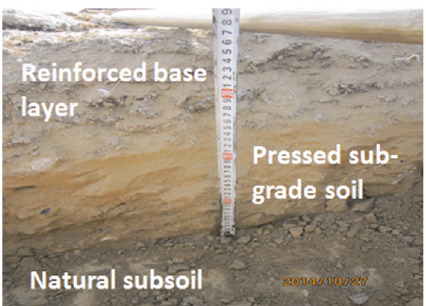
Figure 13: Conditions of bottompartof baselayer andsoil base after construction has